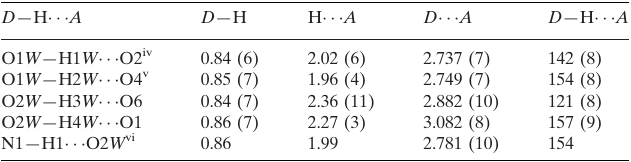
Hydrogen-bond geometry (A˚ , (cid:3)